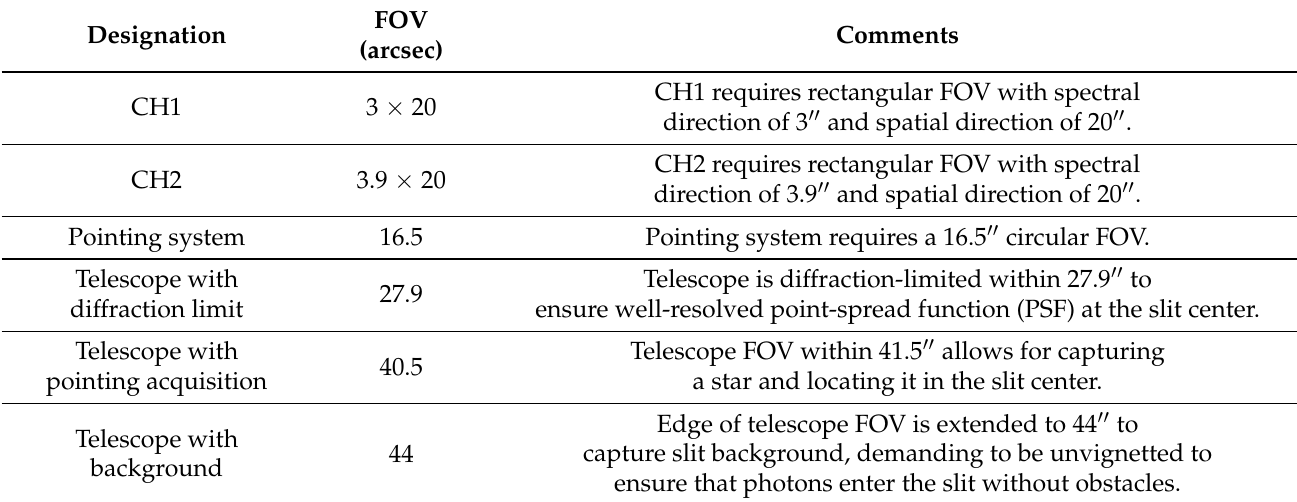
Table 4. Summary of field of view (FOV)